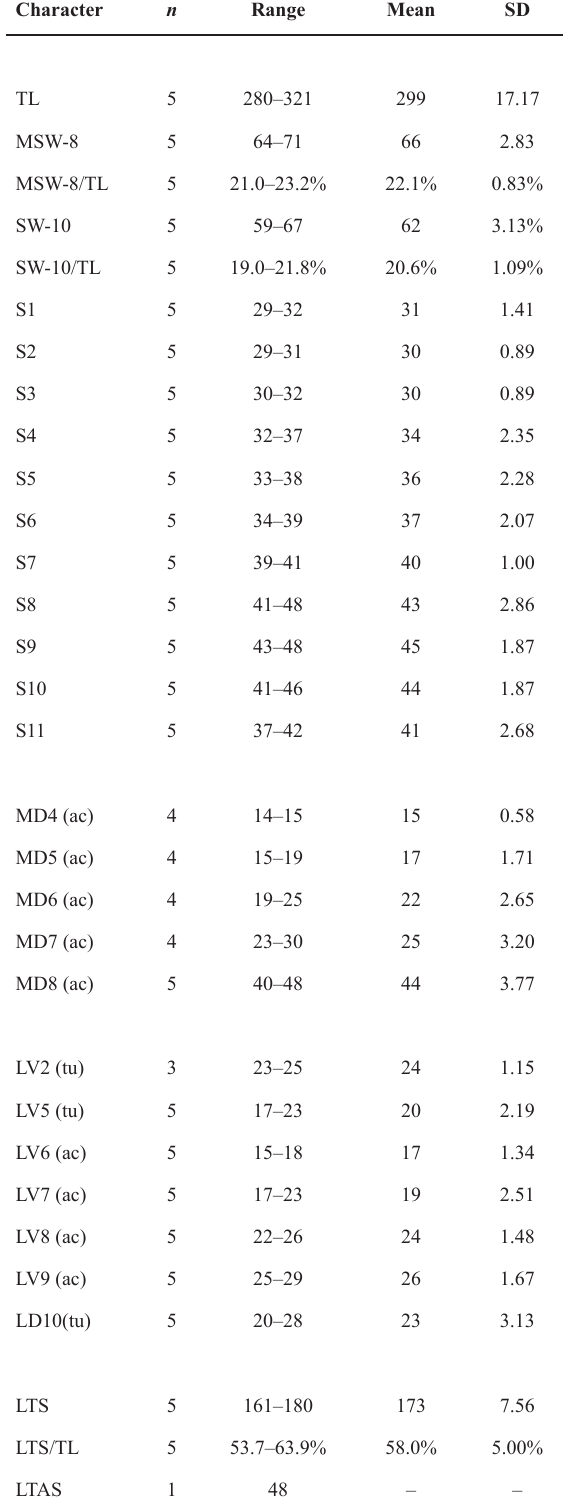
Table 19. Measurements from light microscopy for Echinoderes sp. from Havelock Island, Andaman Islands (in µm), including number of measured specimens ( n ) and standard deviation